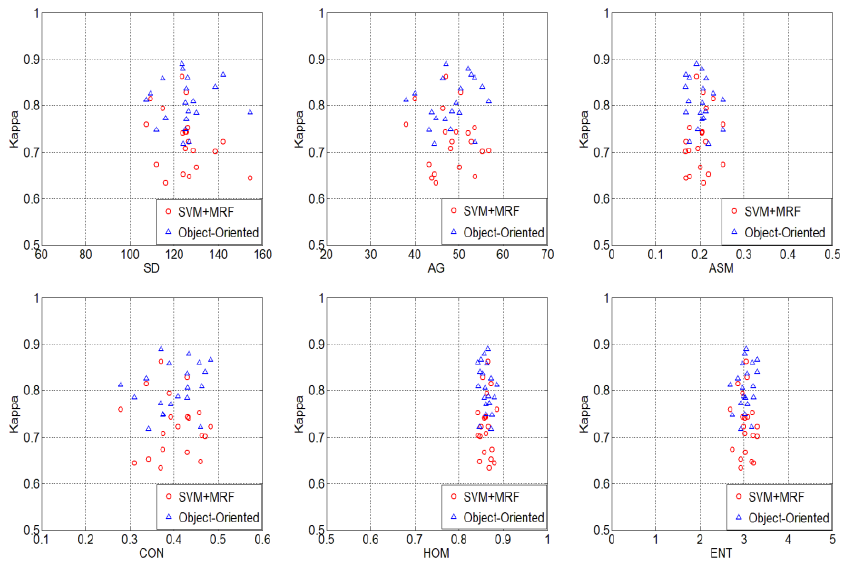
Figure 5. The relationship of the quality index and classification accuracy with different